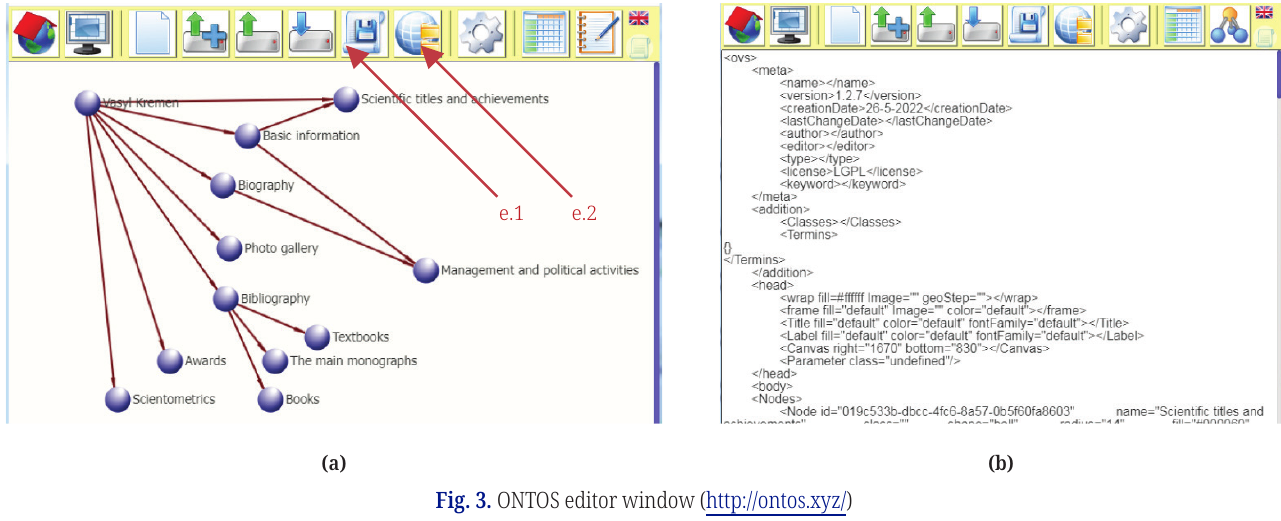
Fig. 3. ONTOS editor window